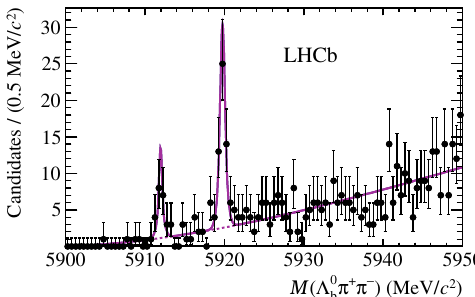
Figure 14. Invariant mass distribution for Λ 0 ∗ b → Λ 0 b π + π −